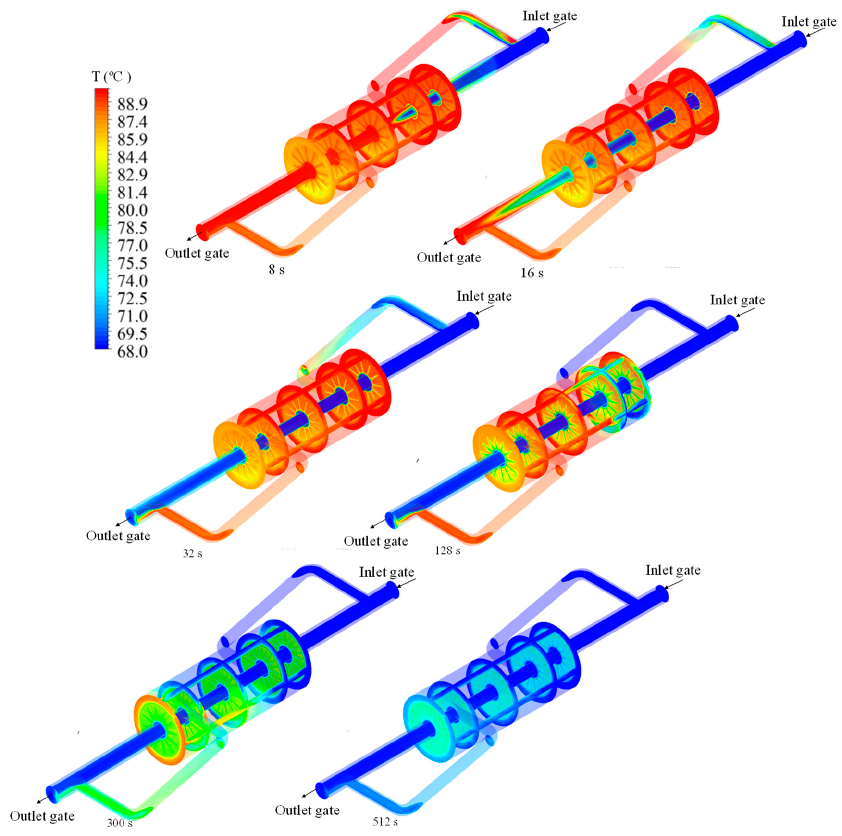
Figure 9. Temperature distribution during the time required to remove the HHTF from the TTHX.